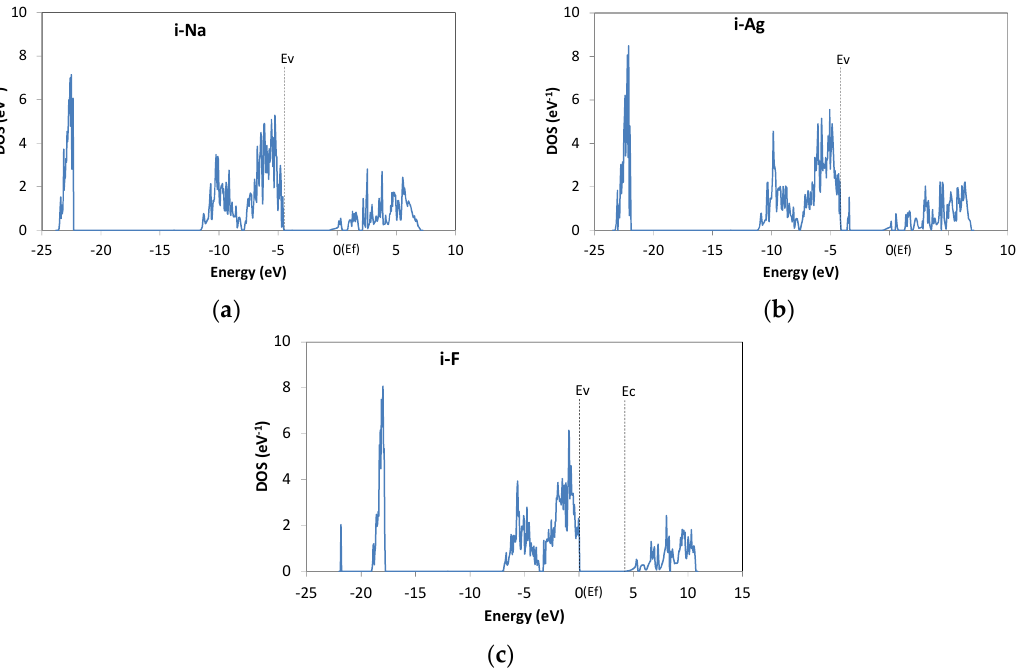
Figure 5. DOS of Mg(OH) 2 with an interlayer impurity. ( a ) Na; ( b ) Ag; ( c ) F.